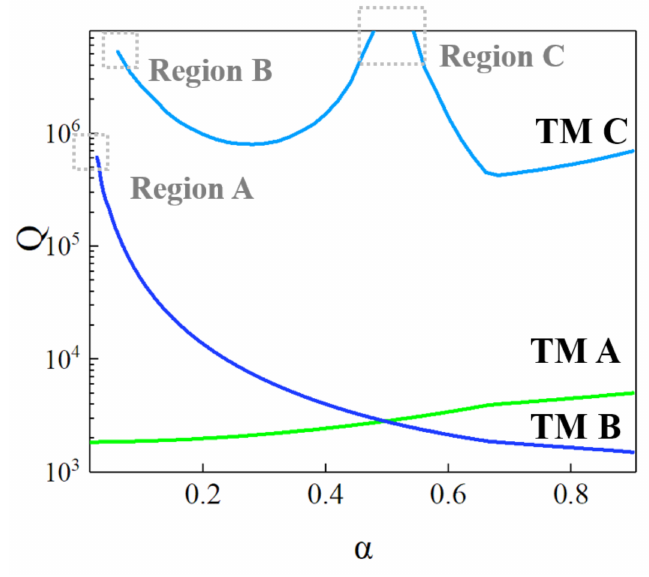
Figure 4. The variation in Q factor of three modes with the asymmetry parameter α when period is 600 nm. TM B has one BIC in region A, and TM C has two BICs in region B and region